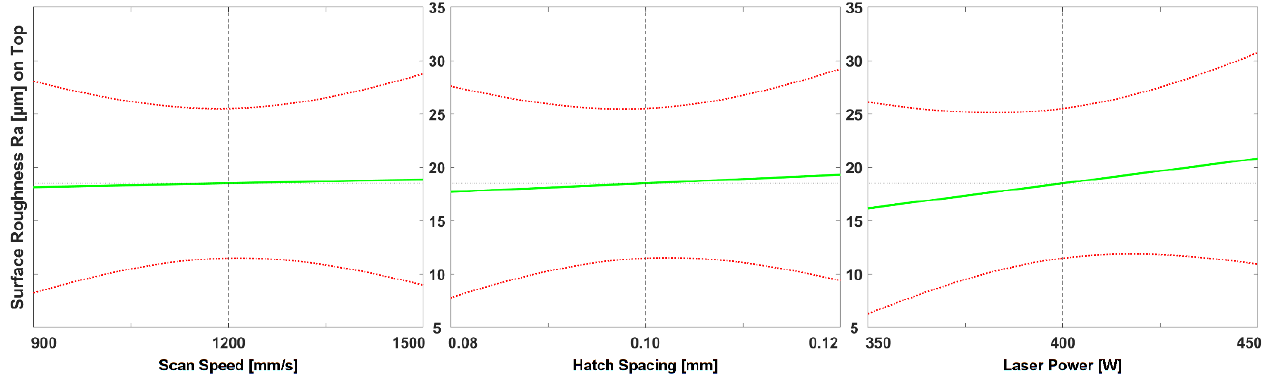
Figure 8. Predicted effects of changes in process parameters on the roughness R a on the top surface, where the green lines are the predictions of surface roughness on top surfaces and the dotted red lines present the 95% confidence bounds.